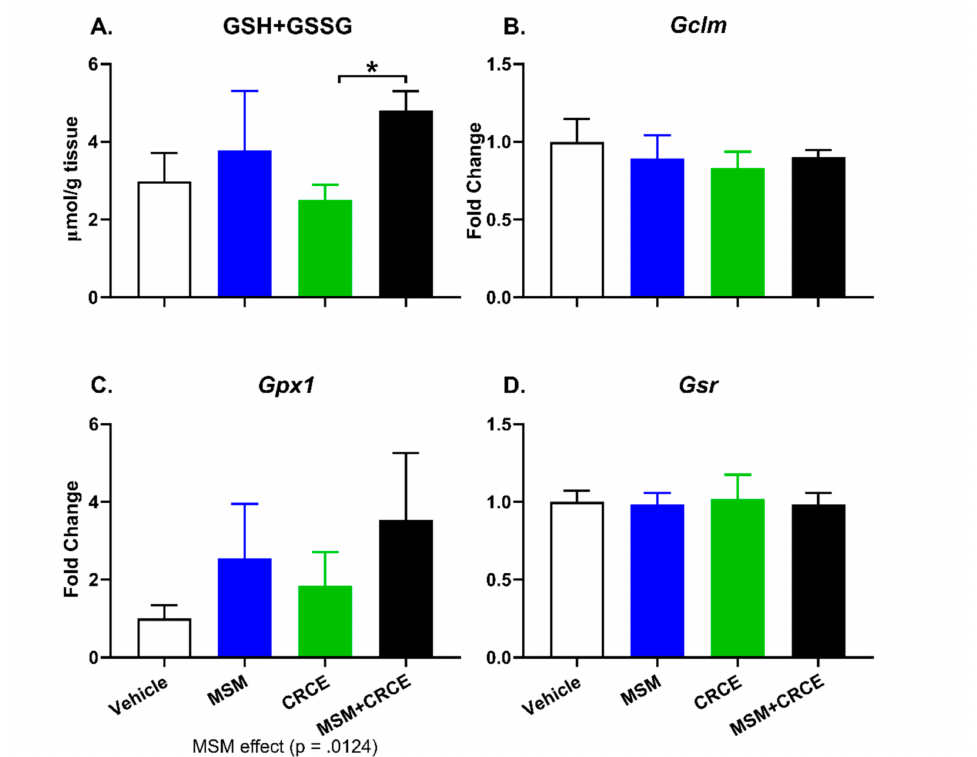
Figure 5. E ff ects of MSM, CRCE, or MSM / CRCE on intrahepatic synthesis of glutathione and the expression of genes associated with the synthesis of glutathione. ( A ) Intrahepatic concentrations of total glutathione; ( B – D ) mRNA levels of ( B ) Gclm , ( C ) Gpx1 , and ( D ) Gsr in the mouse livers 24 h after the last dose of CRCE. Gene expression was measured using quantitative real-time (qRT) PCR. Data was analyzed by two-way ANOVA with Bonferroni post-test and are presented as mean ± SD fold change from vehicle ( n = 6–8), with * as p <